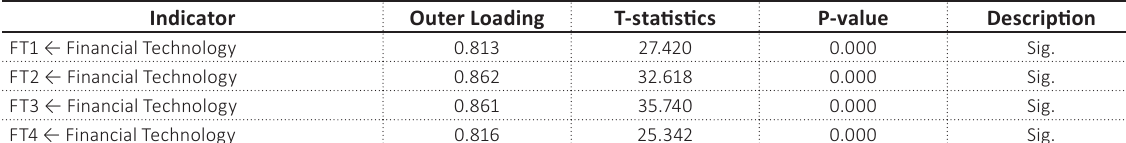
Source: Own elaboration using PLS.